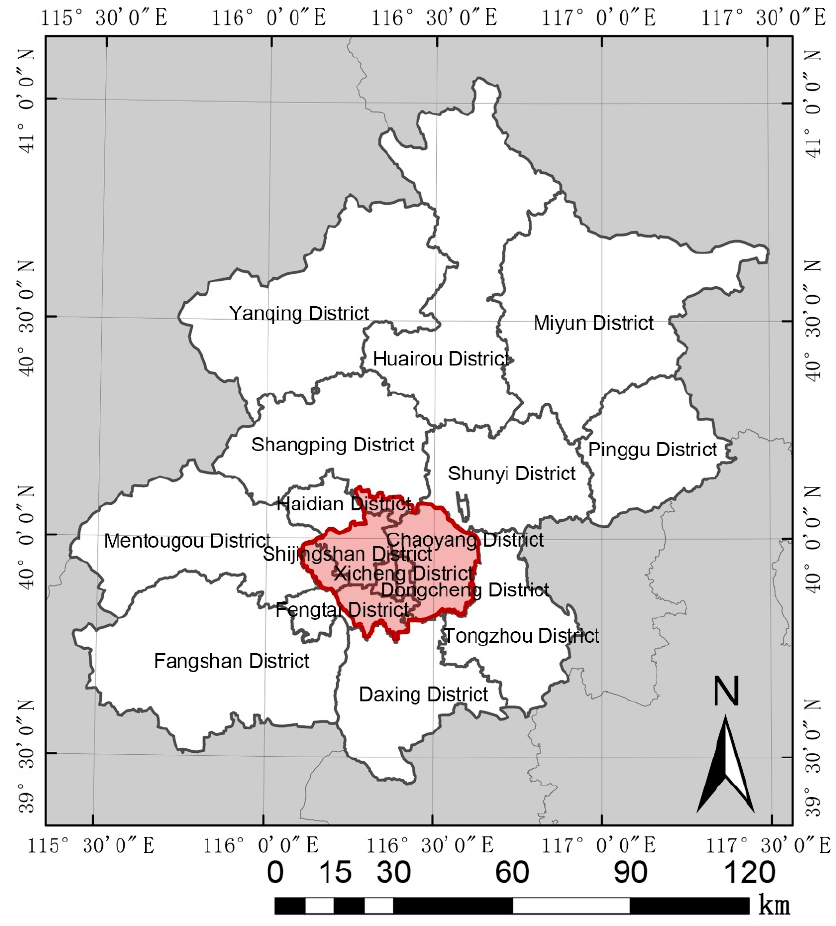
Figure 1. Location of Beijing’s Central District.